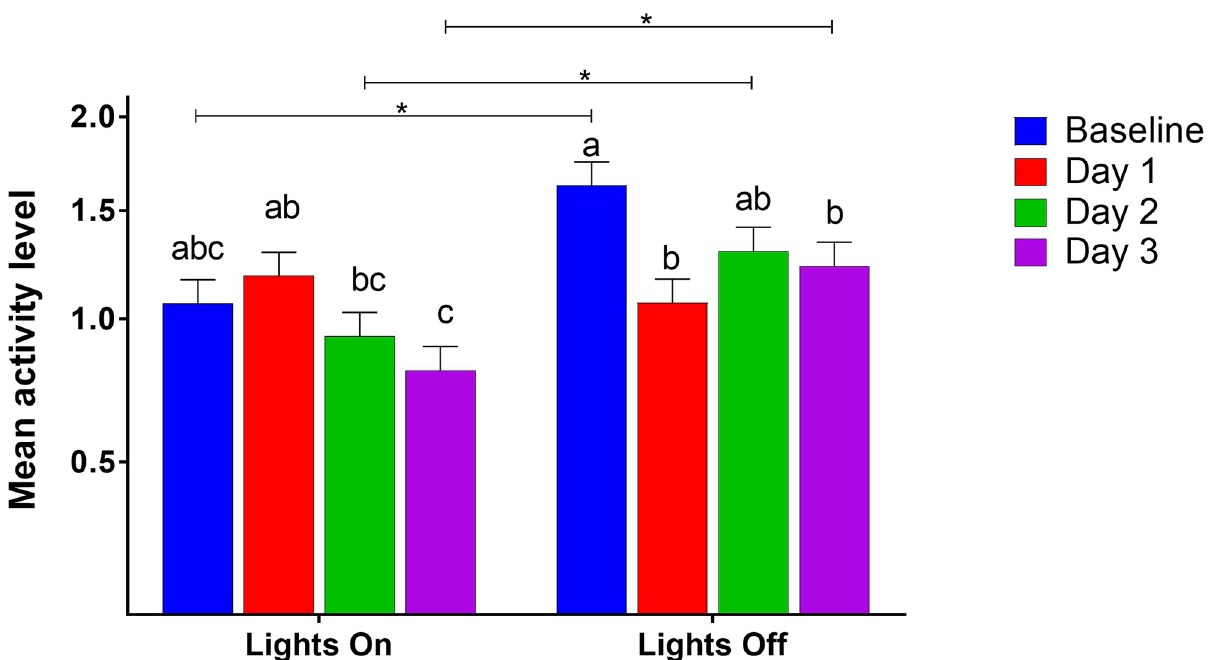
Fig 5. Mean activity level by light phase and day of experiment. Different letters indicate significant differences within categories, bars with asterisks indicate differences between categories (Tukey, P < 0.05). Data were square root transformed for analysis; y-axis is back-transformed. Activity level is a linear measurement from 0 to 3; higher values indicate higher levels of activity. Data presented are LSM and SE.